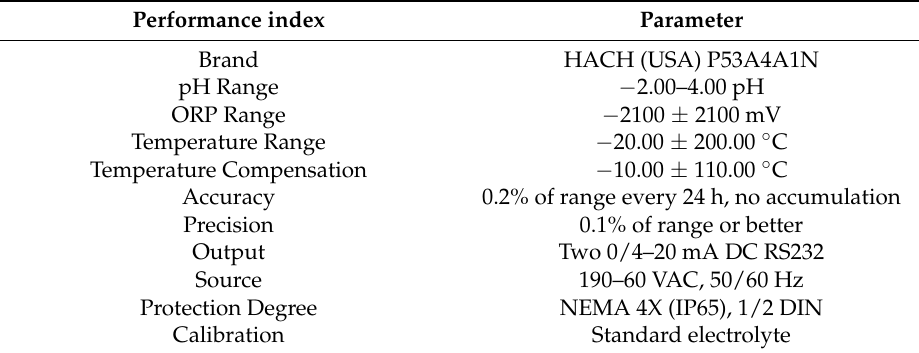
Table 3. Performance of sensor. ORP: oxidation-reduction